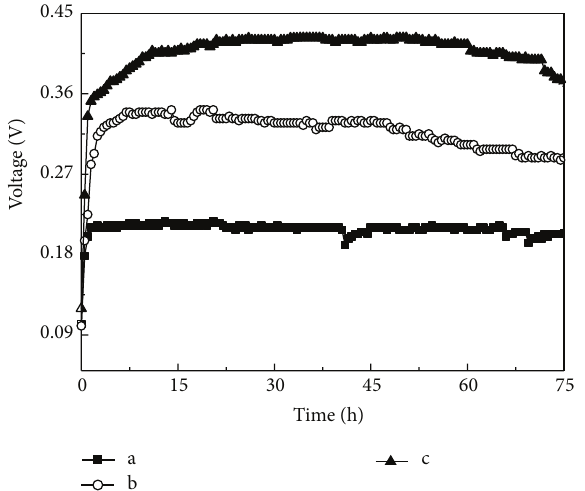
Figure 3: The voltage of MFCs with different cathode catalysts. (a) Cathode without loading catalyst; (b) cathode loading with NSM; (c) cathode loading with